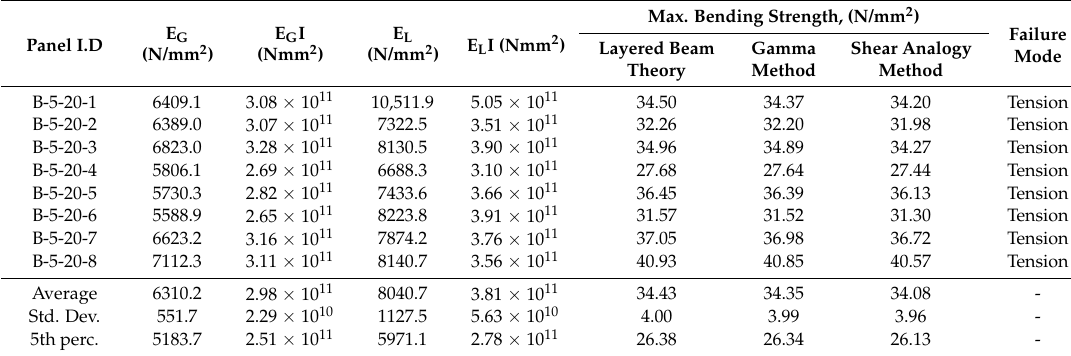
Table 3. Bending test results for five-layer B-5-20 configuration.